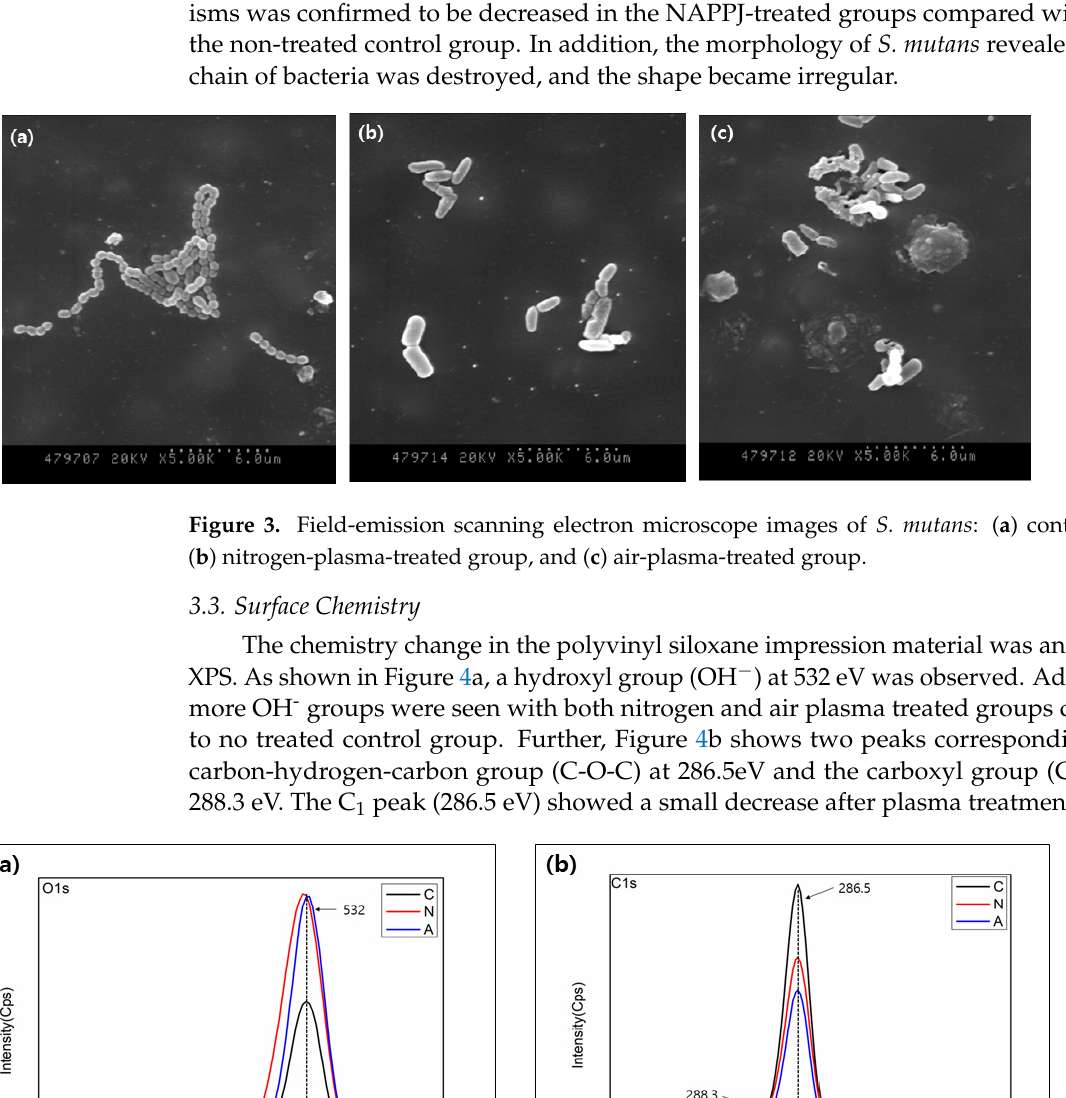
Figure 3. Field ‐ emission scanning electron microscope images of S. mutans : ( a ) control group, ( b ) nitrogen ‐ plasma ‐ treated group, and ( c ) air ‐ plasma ‐ treated group.